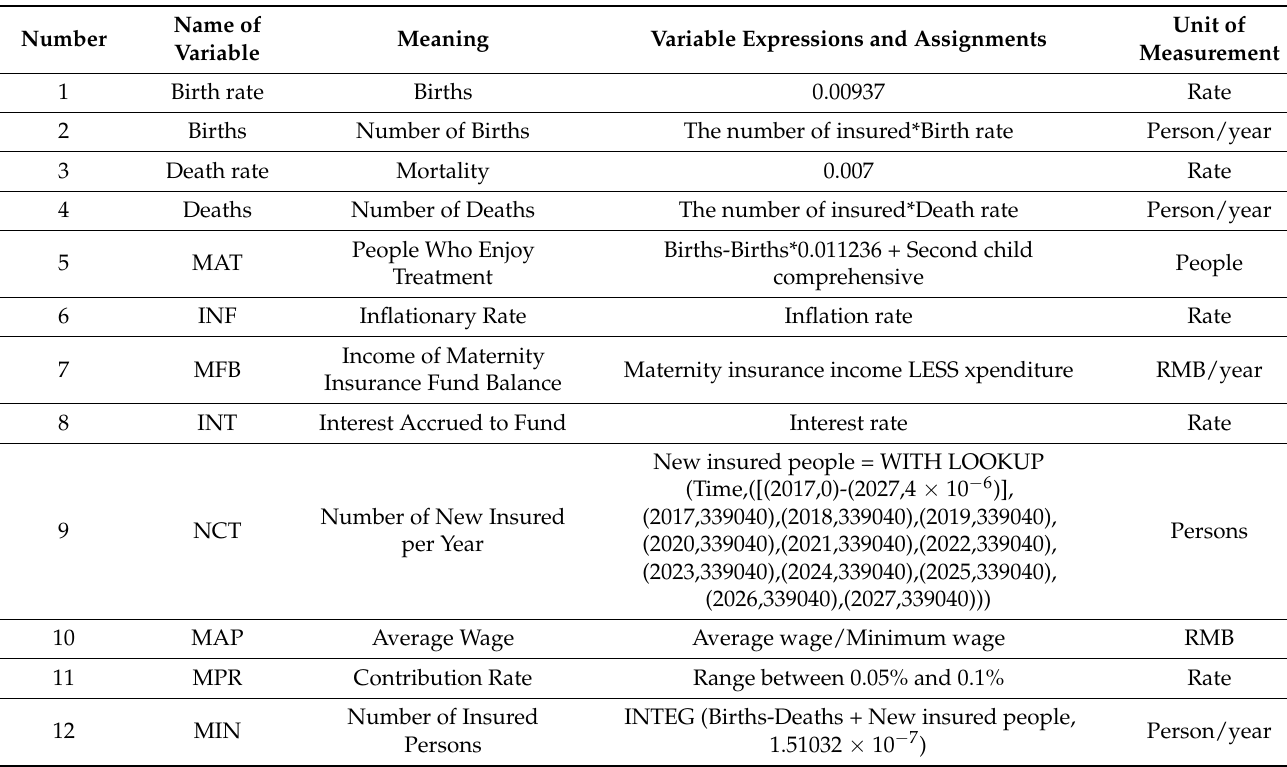
Table 1. Definition of variables and measurement